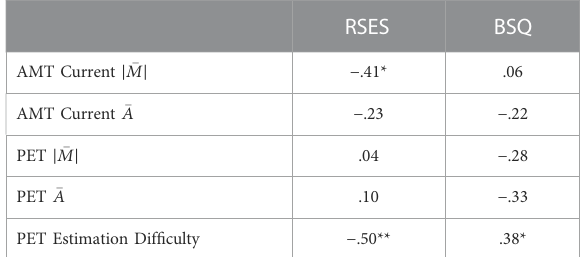
TABLE 3 Correlations between RSES and BSQ scores and the body weight misestimations (cid:1) M and (cid:1) A inAMTandPETaswellastheestimationdif fi culty in PET. Single-asterisks indicate signi fi cant and double-asterisks highly signi fi cant p